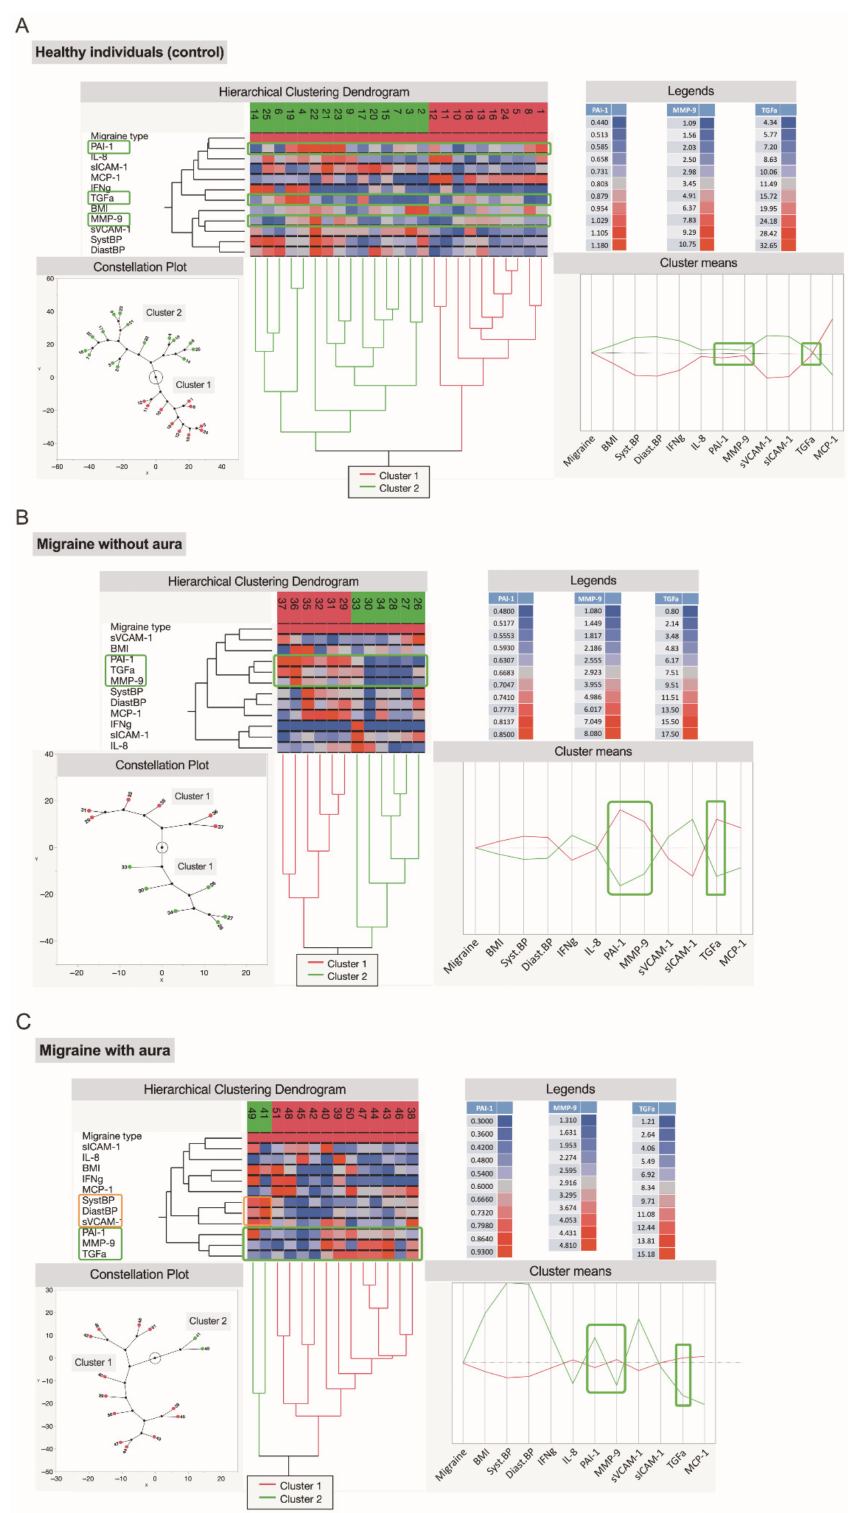
Figure 6. Cluster analysis of the studied groups: ( A ) healthy individuals (control), ( B ) patients with migraine without aura, ( C ) patients with migraine with aura. Results represented as hierarchical clustering dendrogram with constellation plot and cluster means. Green rectangles in this model mark three cytokines (PAI-1, TGF α , MMP-9) that could be used as putative markers for distinguishing migraine patients from healthy